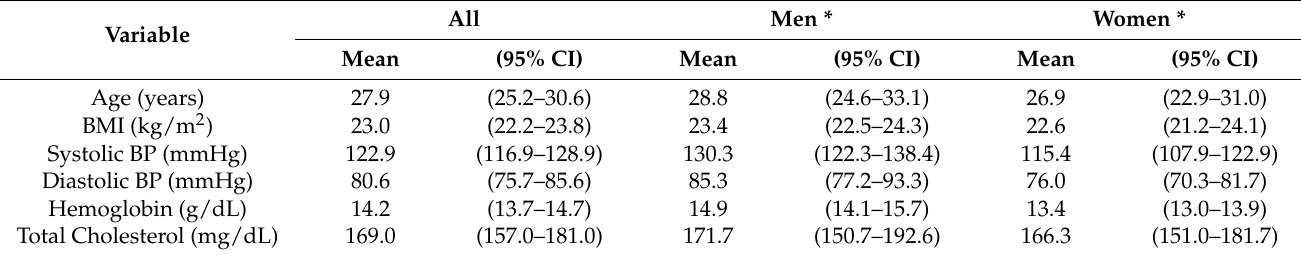
Table 1. Demographic and baseline data.